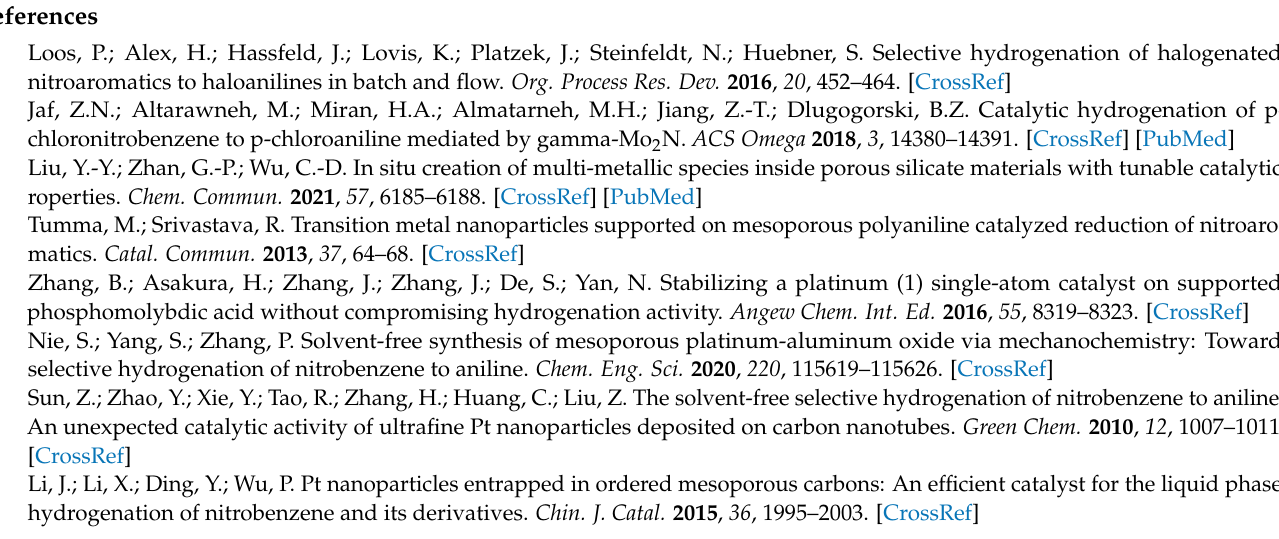
losses of the carbon